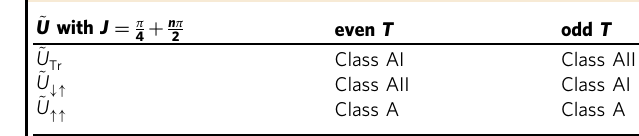
Table 2 Antiunitary symmetry classes for ~ U